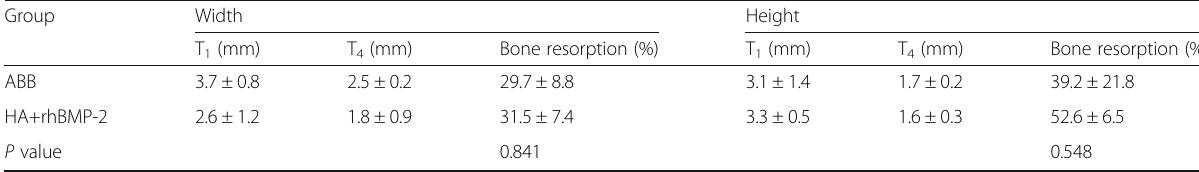
Table 1 Amount of bone augmentation Group